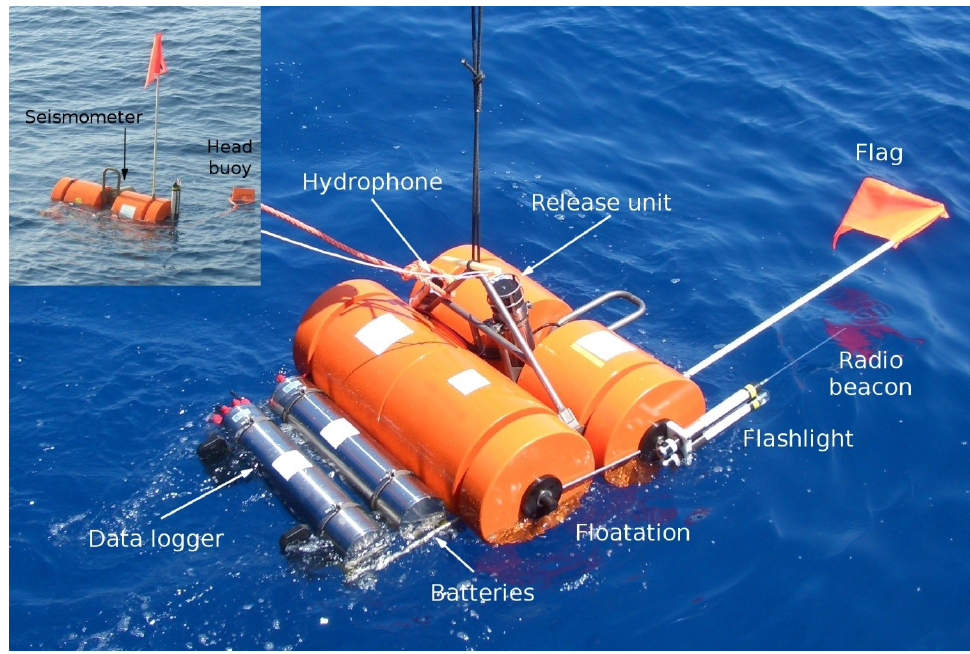
Figure 1: Deployment of a DEPAS ocean-bottom seismometer. Main components are annotated. Inset: OBS after emerging at the sea